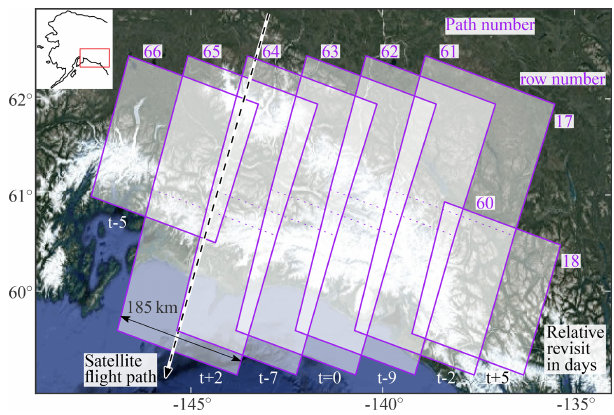
Figure 1. Nominal Landsat 8 footprints used over the study region. The purple text annotates the different satellite paths of Landsat, while the white text indicates the relative overpass time in days with respect to path